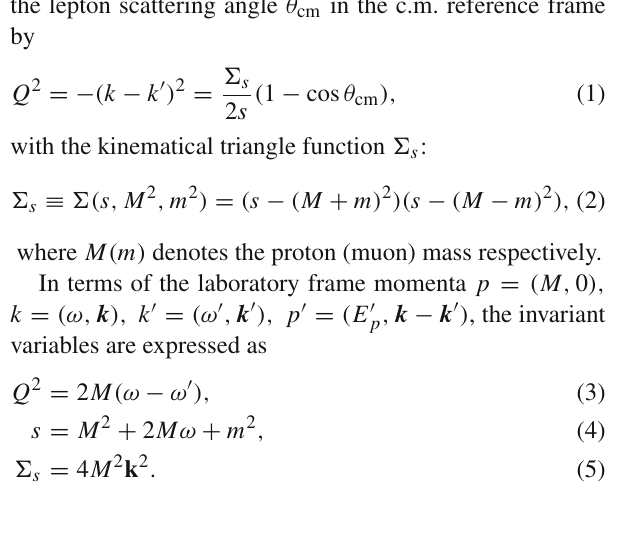
detailed comparison of dispersion relations to the hadronic model calculation for the proton intermediate state TPE con- tribution is given in Appendix